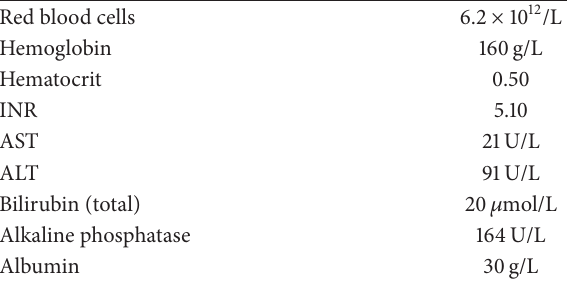
Table 1: Laboratory results on